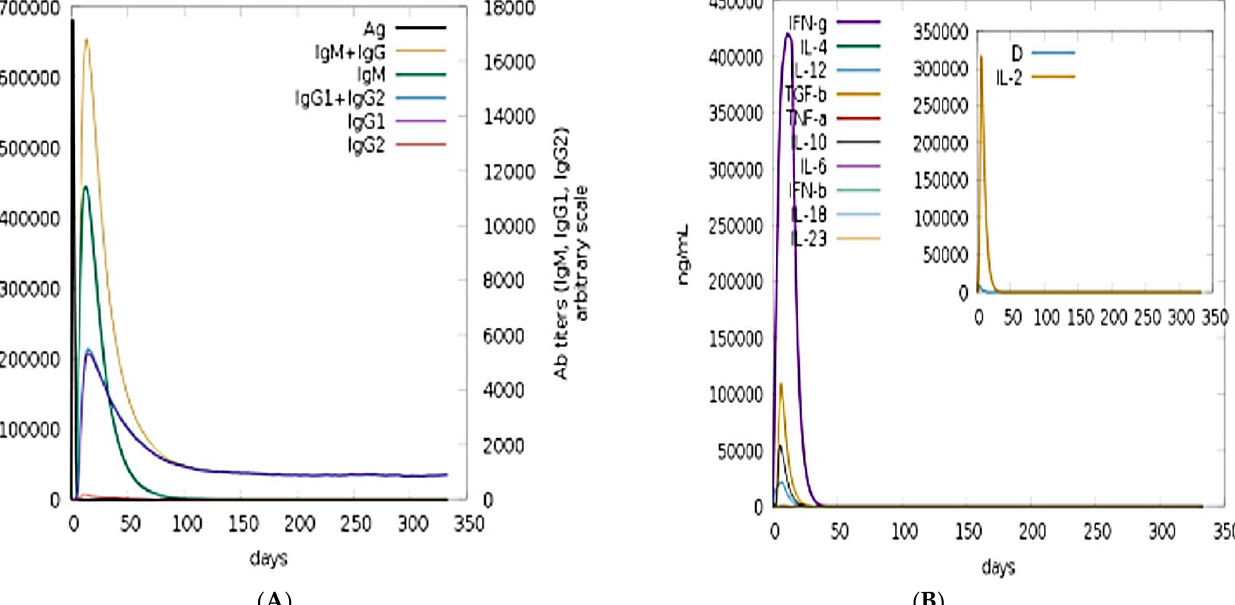
Figure 8. Immune simulations in response to the vaccine antigen: ( A ) antibodies count and ( B ) interleukins and cytokines counts in response to the antigen.